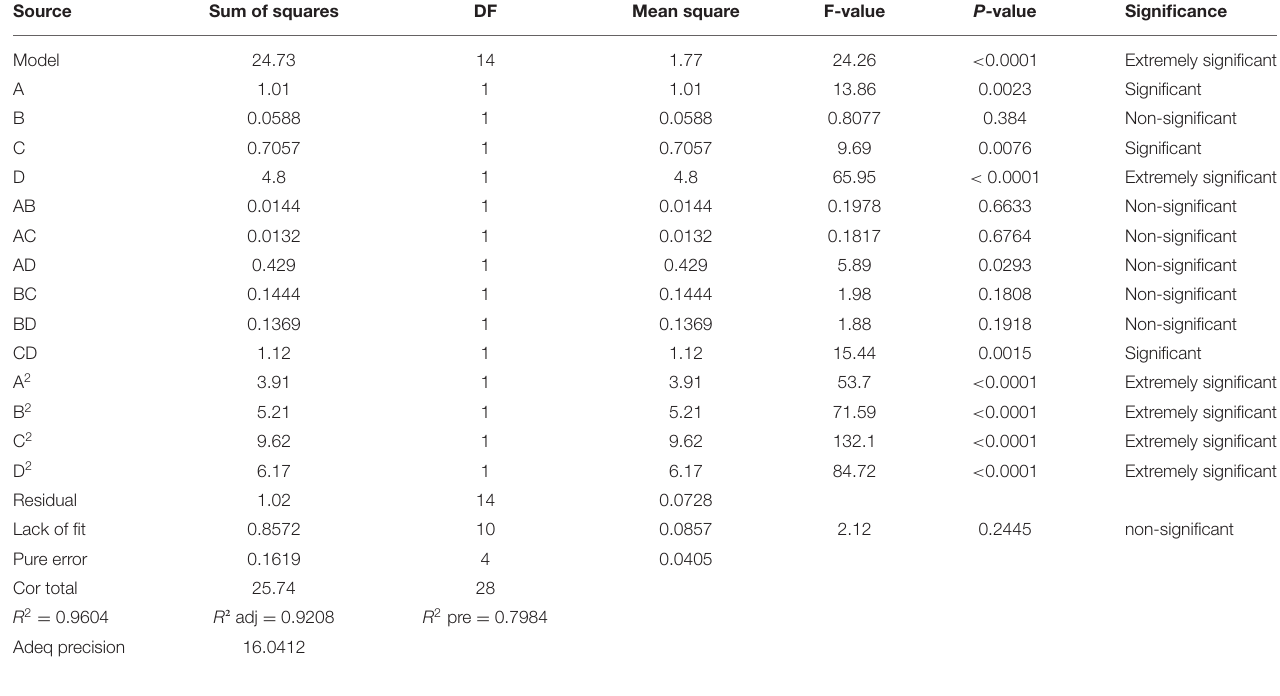
TABLE 3 | Response surface regression model analysis of variance.